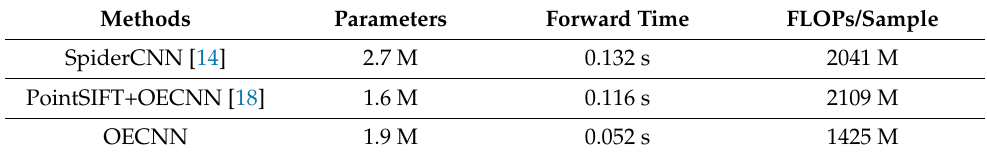
Table 4. Time and space complexity of network architectures for 3D data